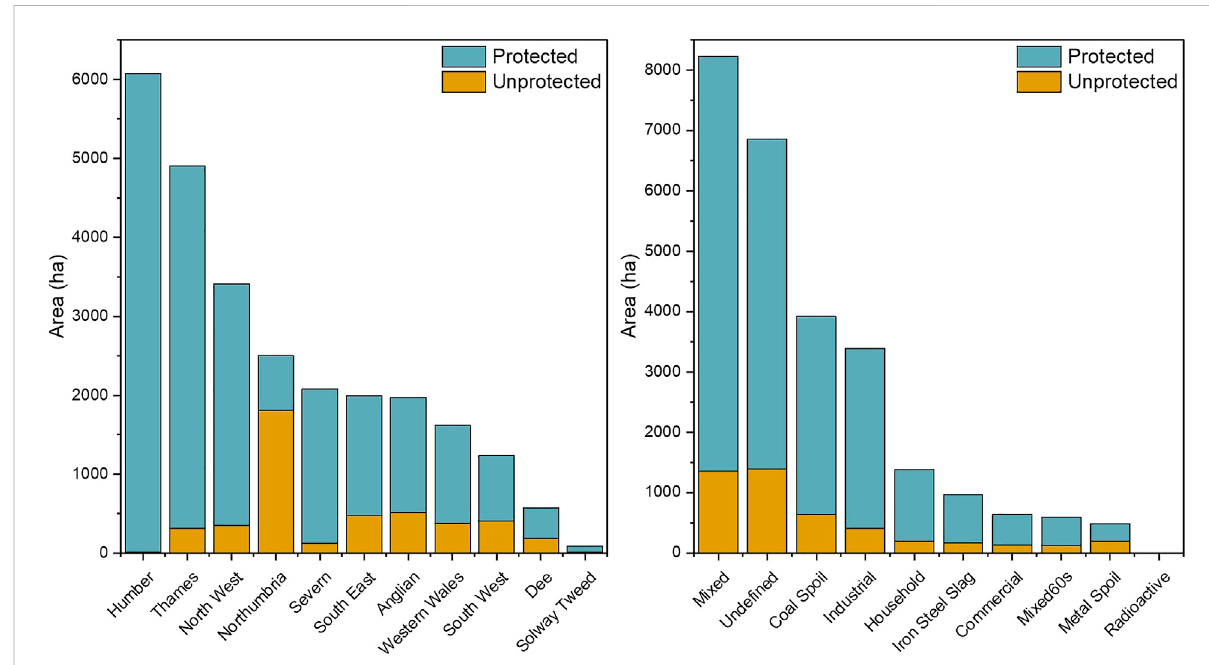
FIGURE 2 TotalareaofprotectedandunprotectedcoastallegacywastedepositsinEnglandandWales.Left:areaperRiverBasinDistrict(RBD).Right:area by identi fi ed waste